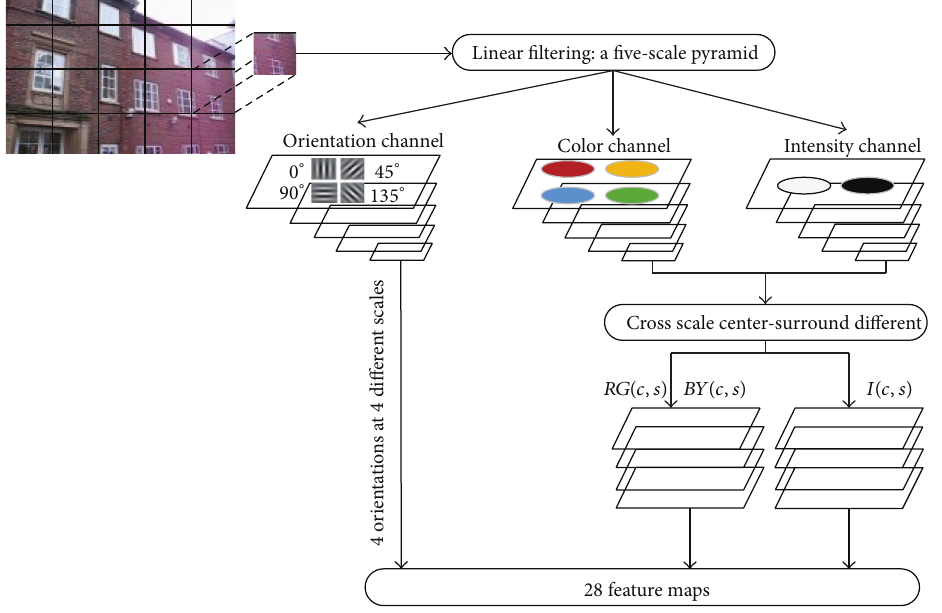
Figure 3: Each subregion’s visual feature extract